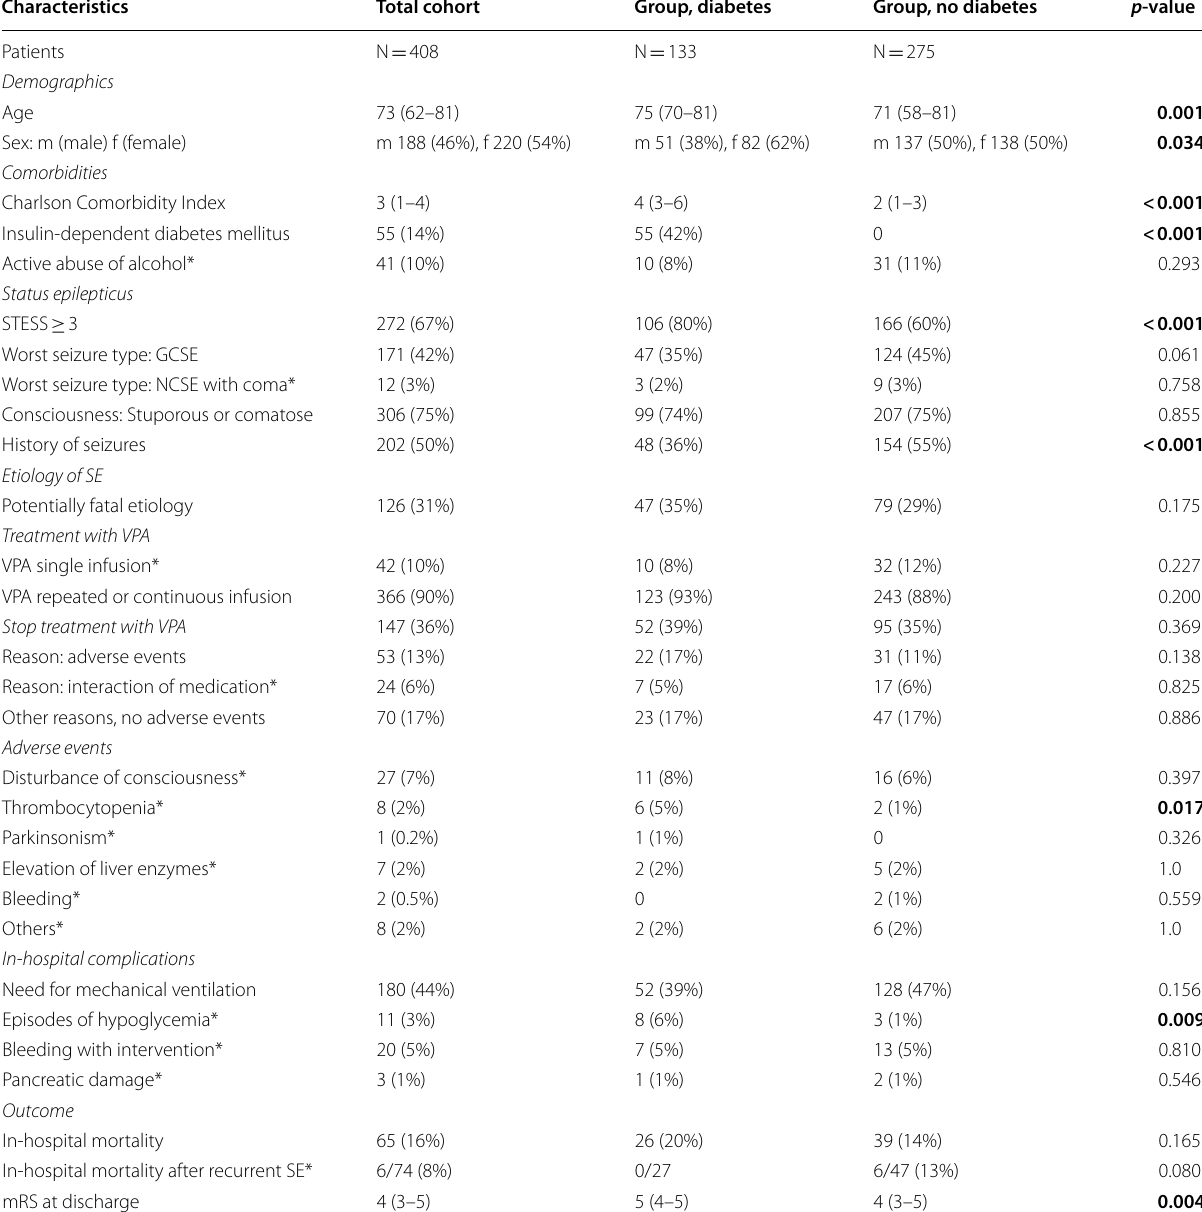
Table 1 Characteristics of the total study cohort and both groups (patients with or without known